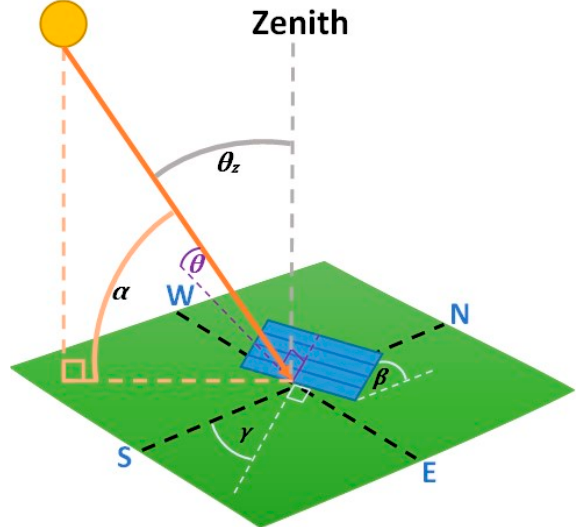
Figure 2. Illustrated relationship between direct solar radiation angle of incidence on a plane inclined at an angle β and rotated within the azimuth by the angle γ .